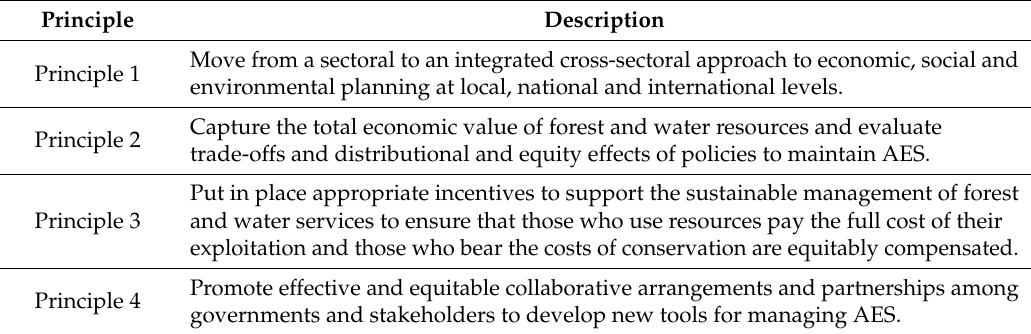
Table 1. Principles for forest and water management in the Anthropocene (Recommendations for decision makers stated in the Shiga Declaration (Final): Adopted on 22 November 2002, Shiga, Japan